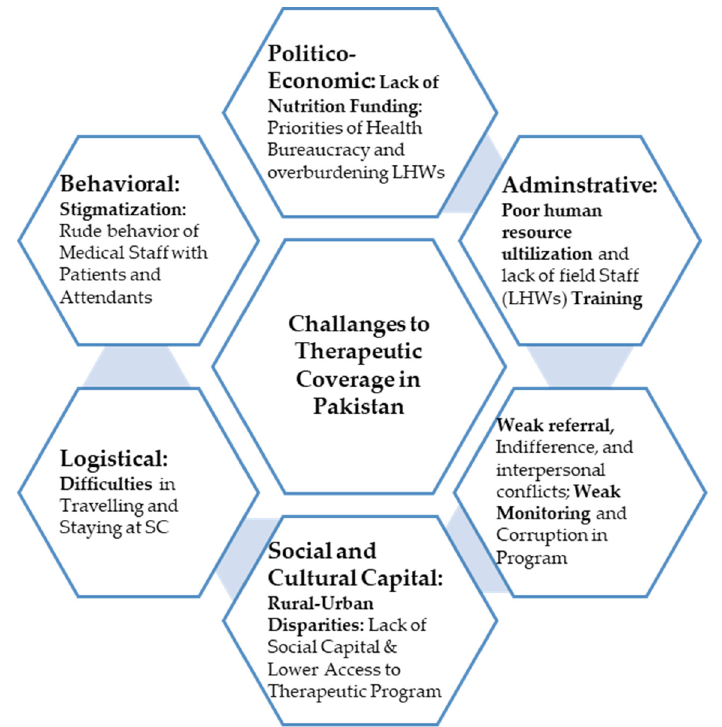
Figure 1. Graphical abstract of Significant Barriers to Optimal Therapeutic Coverage in Rural and Southern Pakistan.